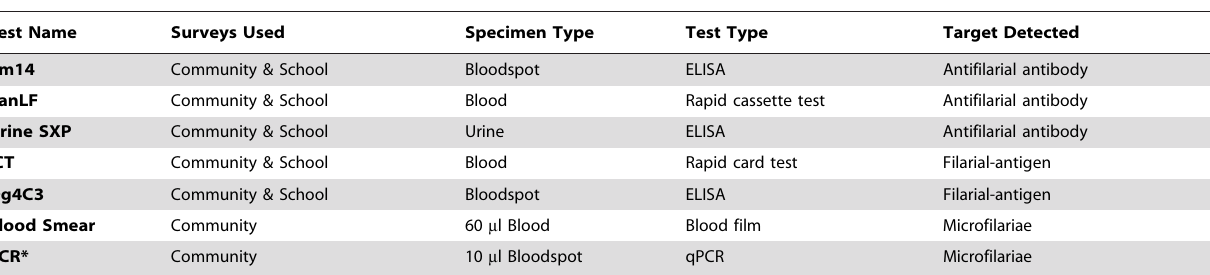
Table 2. Diagnostic test